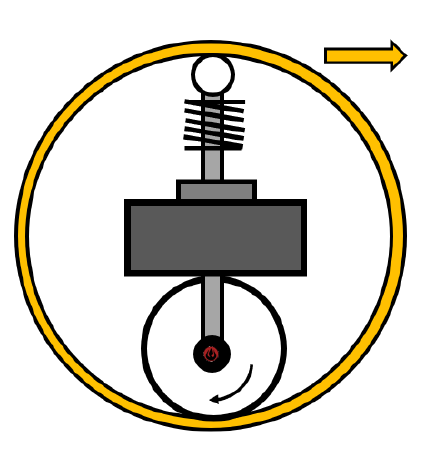
Figure 1. Principle sketch of a single wheel